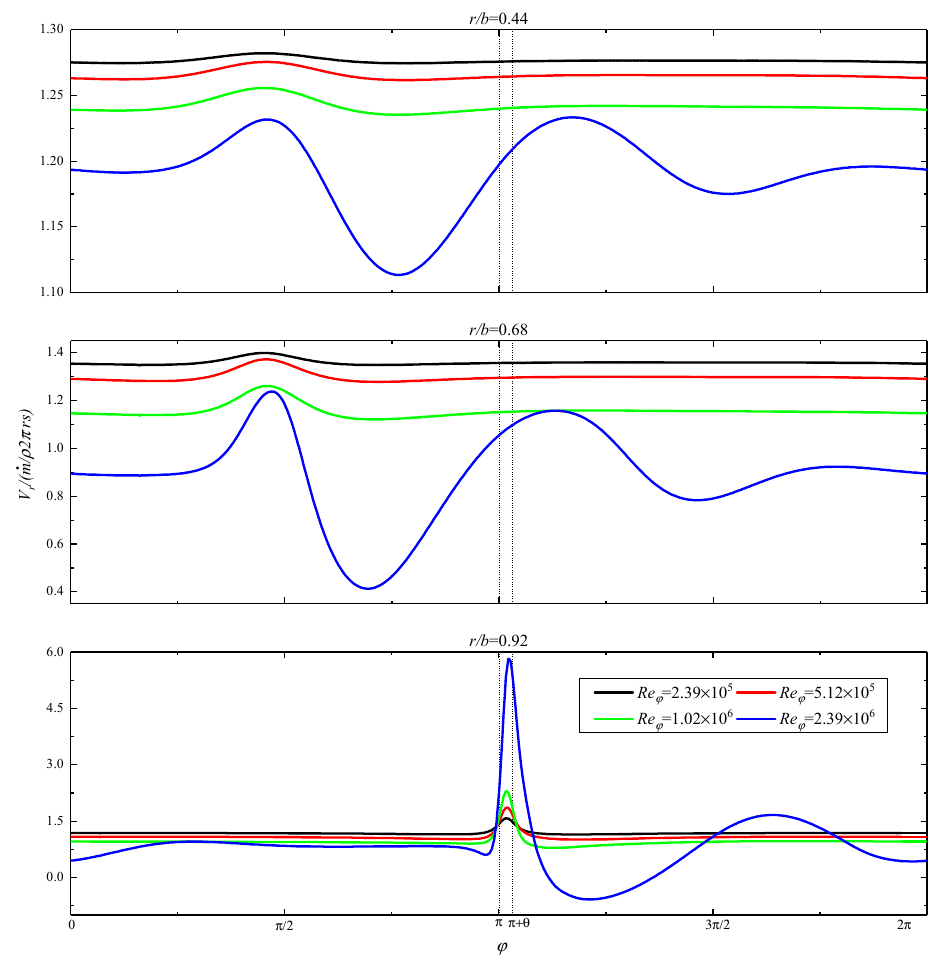
Figure 10. Dimensionless radial velocity for C w = 10,137, E = 0.2, θ = 0.1 at z / s = 0.5. Figures 11 and 12 show the distribution of the dimensionless radial velocity in the circumferential direction for different E and θ numbers. As can be seen from the figures, the E and the θ have a similar effect on the radial velocity distribution. The upstream areas are more affected at the low-radius locations, while the downstream areas are more affected at the high-radius locations. In addition, the high-radius position is more affected than the low-radius position. The standard deviation of the radial velocity at high-radius locations is about one order of magnitude larger than that at low radii. For E = 0.4, the standard deviation of the radial velocity at r / b = 0.44, 0.68, and 0.92 is 0.00447, 0.02628, and 0.14153, respectively. One phenomenon is worth noting in Figure 11. An increase in the E has little effect on the distribution pattern of the radial velocities, which are essentially symmetrically distributed. For r / b = 0.92 and E = 0.04, 0.2, and 0.4, the skewness (which can be used to measure the asymmetry of the distribution) is 5.39, 5.70, and 5.84, respectively, while the kurtosis (which can be used to measure the steepness of the distribution) is 32.07, 35.63, and 37.34,